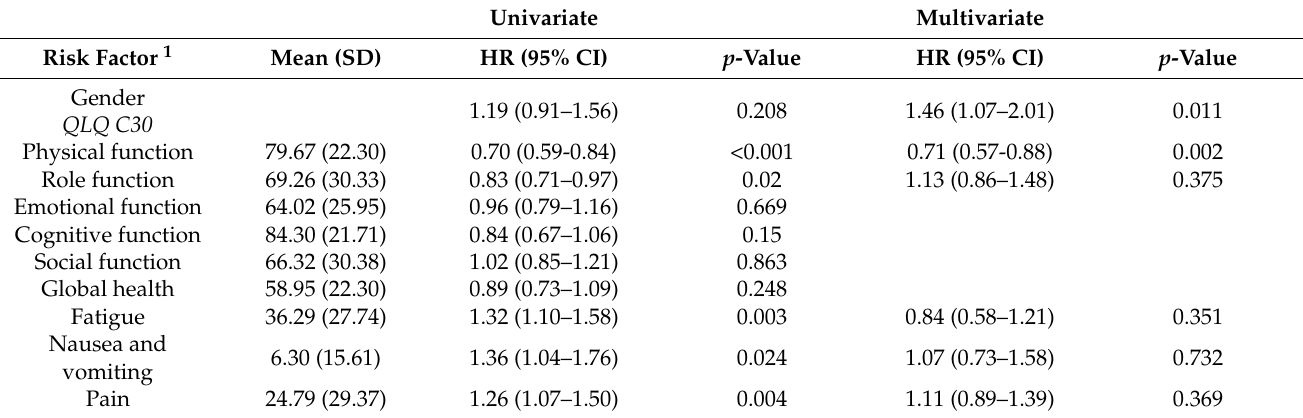
Figure 4. Baseline scores Kaplan–Meier plots for overall survival and ( A ) role function, ( B ) fatigue, ( C ) pain and ( D ) appetite loss, 72-month OS% in brackets. Table 4. Overall survival of age-adjusted hazard ratios for baseline QLQ C30 and QLQ